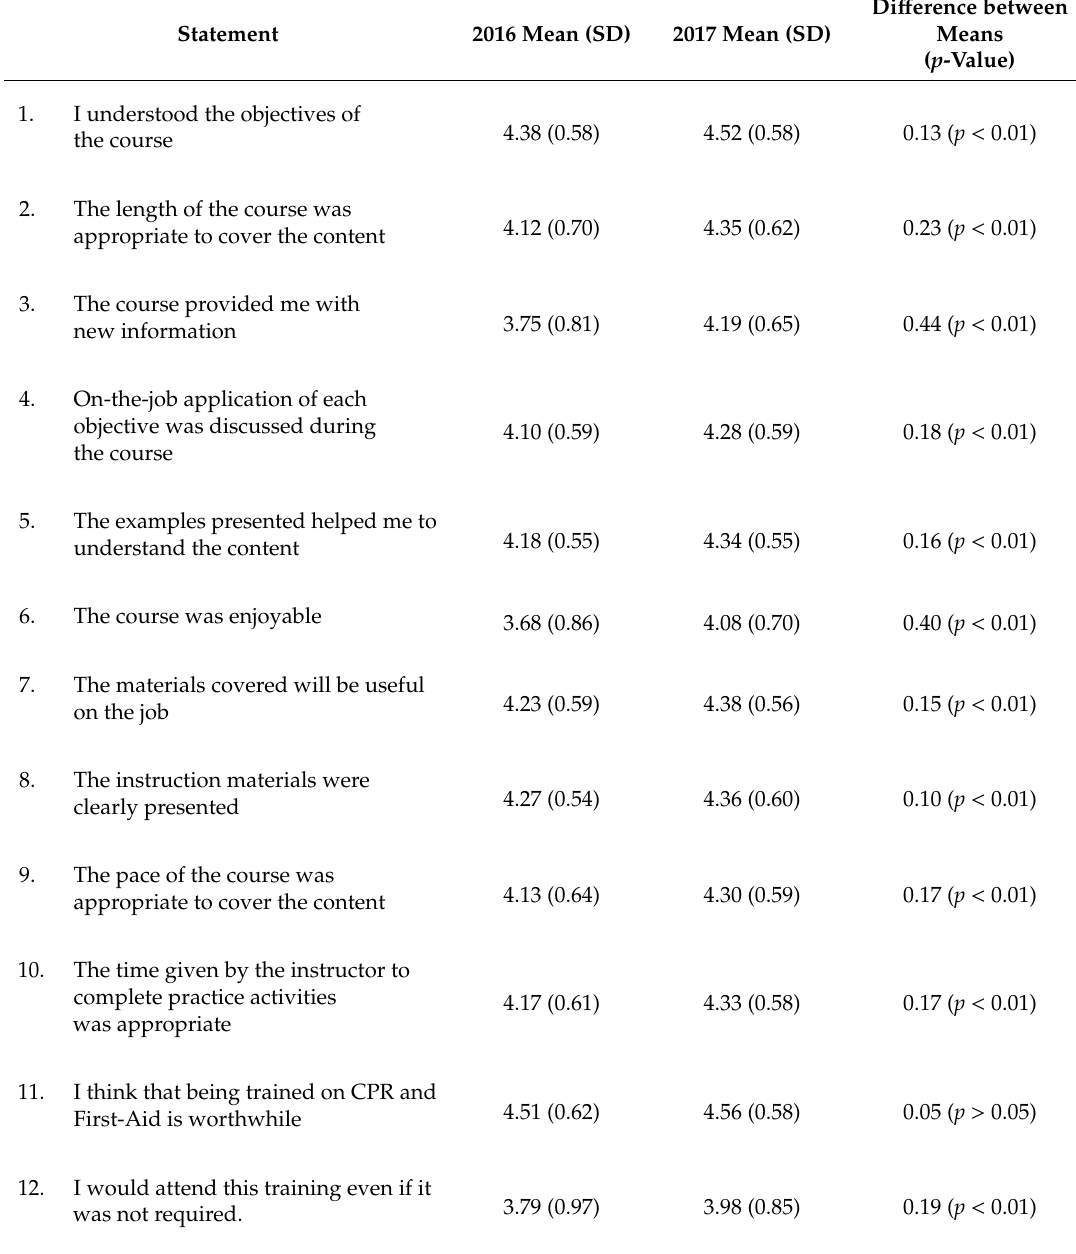
Table 2. Training survey responses: baseline (2016) vs. update